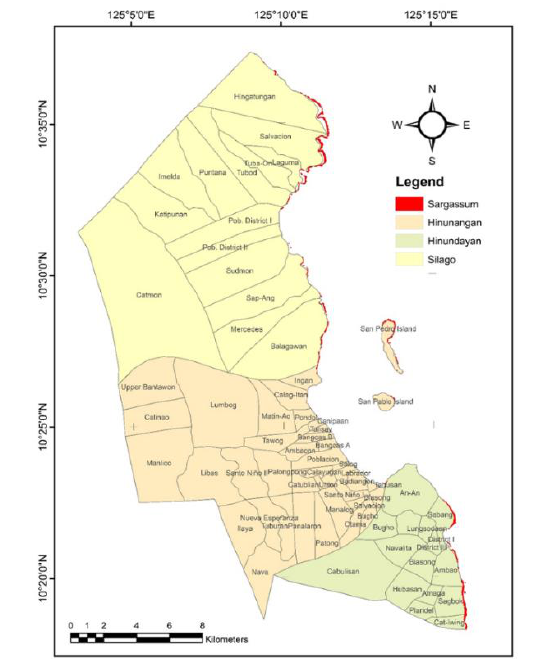
Figure 5. Sargassum map from classification of Sentinel 2